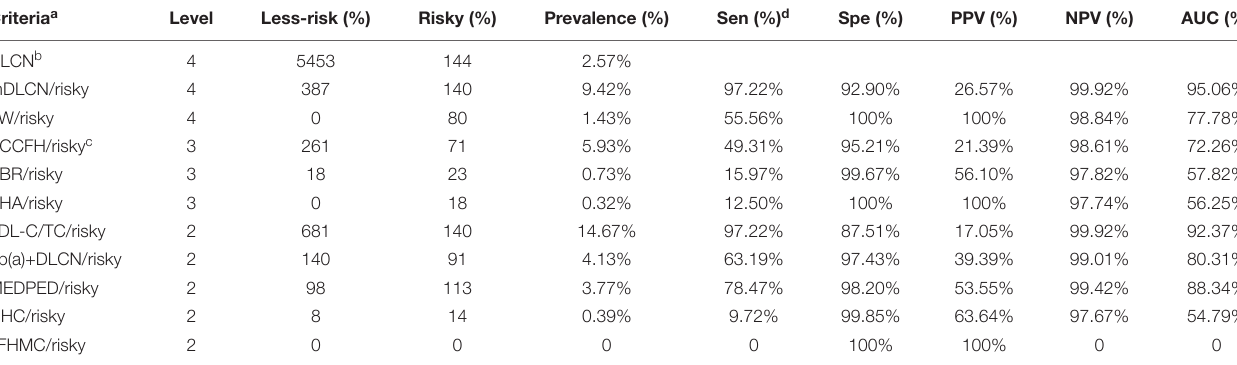
TABLE 3 | The prevalence and the performance of 10 different criteria compared with DLCN. Criteria a